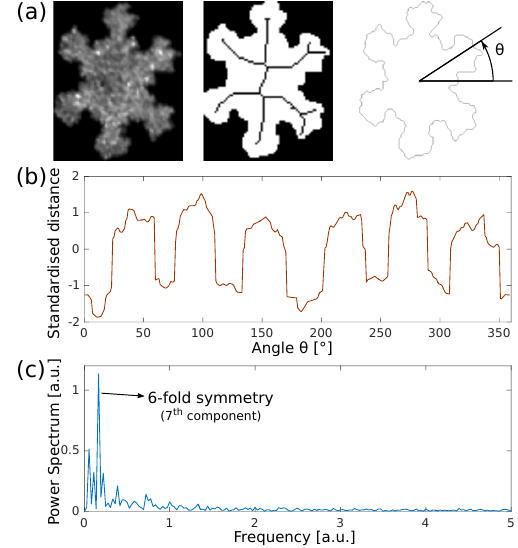
Figure 2. Illustration of the particle skeleton and symmetry feature extraction process on a sectored plate: (a) original MASC image, particle skeleton and illustration of the angular distance-to-centroid calculation; (b) standardised angular distance-to-centroid computed every 1 degree; and (c) Fourier power spectrum corresponding to the angular signal above, in arbitrary units (a.u.). The seven (including 0) first components of the power spectrum are used as descriptors for hydrometeor